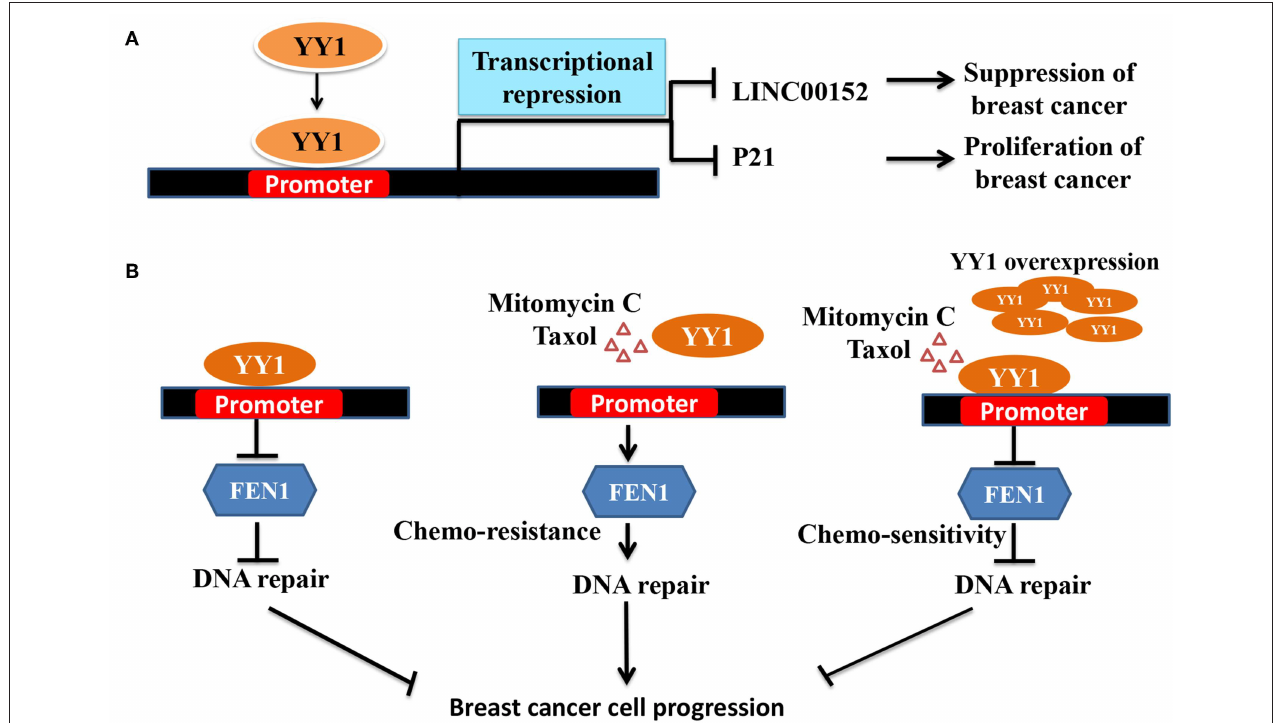
FIGURE 2 | Schematic representation of YY1 mediated transcriptional repression leading breaset cancer suppression/progression. (A) YY1 binds to promoter region of LINC00152 and P21, and represses their expression levels, which lead to tumor suppression and progression, respectively. (B) In some groups of breast cancer patients YY1 was shown to function as tumor suppressor. FEN1 levels have been reported to be high in breast cancer cells and helps in tumor growth ( 115). Owing to its important role in DNA damage repair and replication, targeting FEN1 was shown to inhibit tumor growth. YY1 was shown to bind to FEN1 promoter and repress FEN1 expression leading to better survival of cancer patients. Chemotherapeutic agents including mitomyin C and Taxol reduce YY1 expression leading to elevated levels of FEN1 and drug resistance and tumor growth. However, ectopic expression of YY1 can restore the sensitization of breast cancer cells to chemotherapeutic agents by repressing